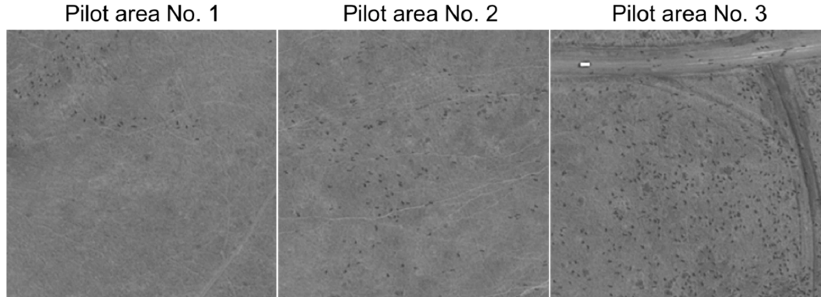
Figure 2. The panchromatic band of the GeoEye-1 image taken on 11 August 2009, showing large mammals in the Maasai Mara National Reserve. Pilot area No. 1 represents low complexity regarding animal numbers and uniformity of background; Pilot area No. 2 represents moderate complexity; and Pilot area No. 3 represents high complexity. The rectangle visible in the top-left corner of Pilot area No. 3 is a white vehicle.